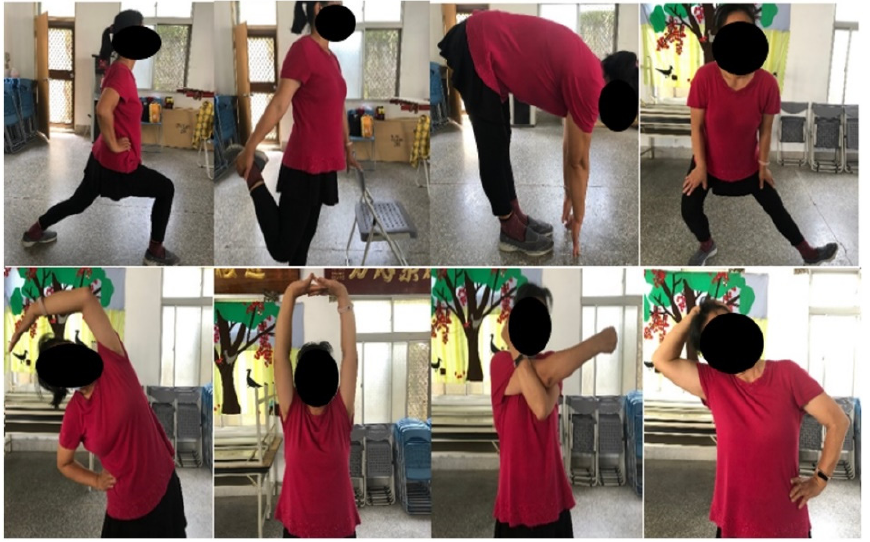
Figure 2. The demonstration of the static stretching protocol.